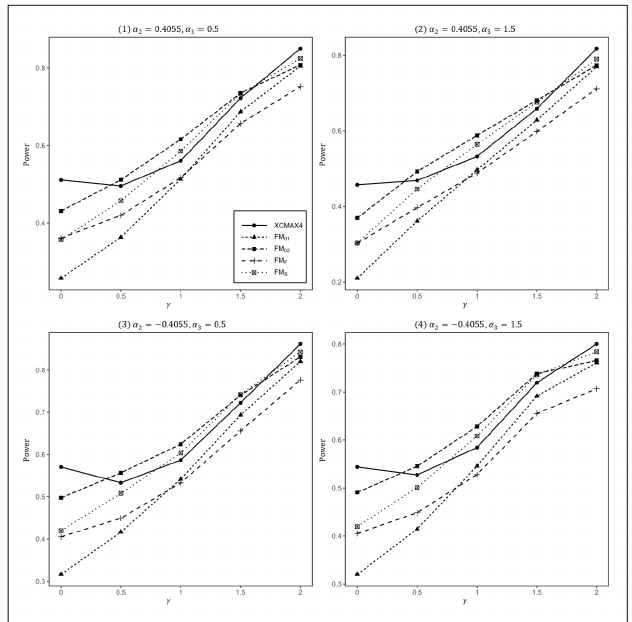
Figure 1. Estimated powers of XCMAX4, FM 01 , FM 02 , FM F , and FM S under various XCI models. The simulation was based on 10,000 replicates with β = 0.15, α 1 = − 5, F = 0, and q f = q m = 0.3.